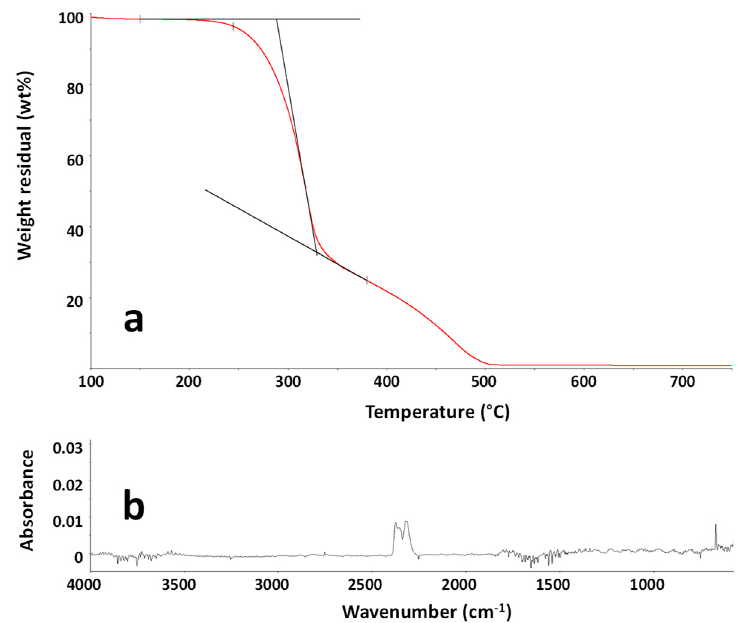
Figure 3. TG curve of the sample MBW in the temperature range 100–750 °C ( a ). FTIR spectrum of the evolved gases from the sample MBW at 260 °C during TG experiment ( b ).